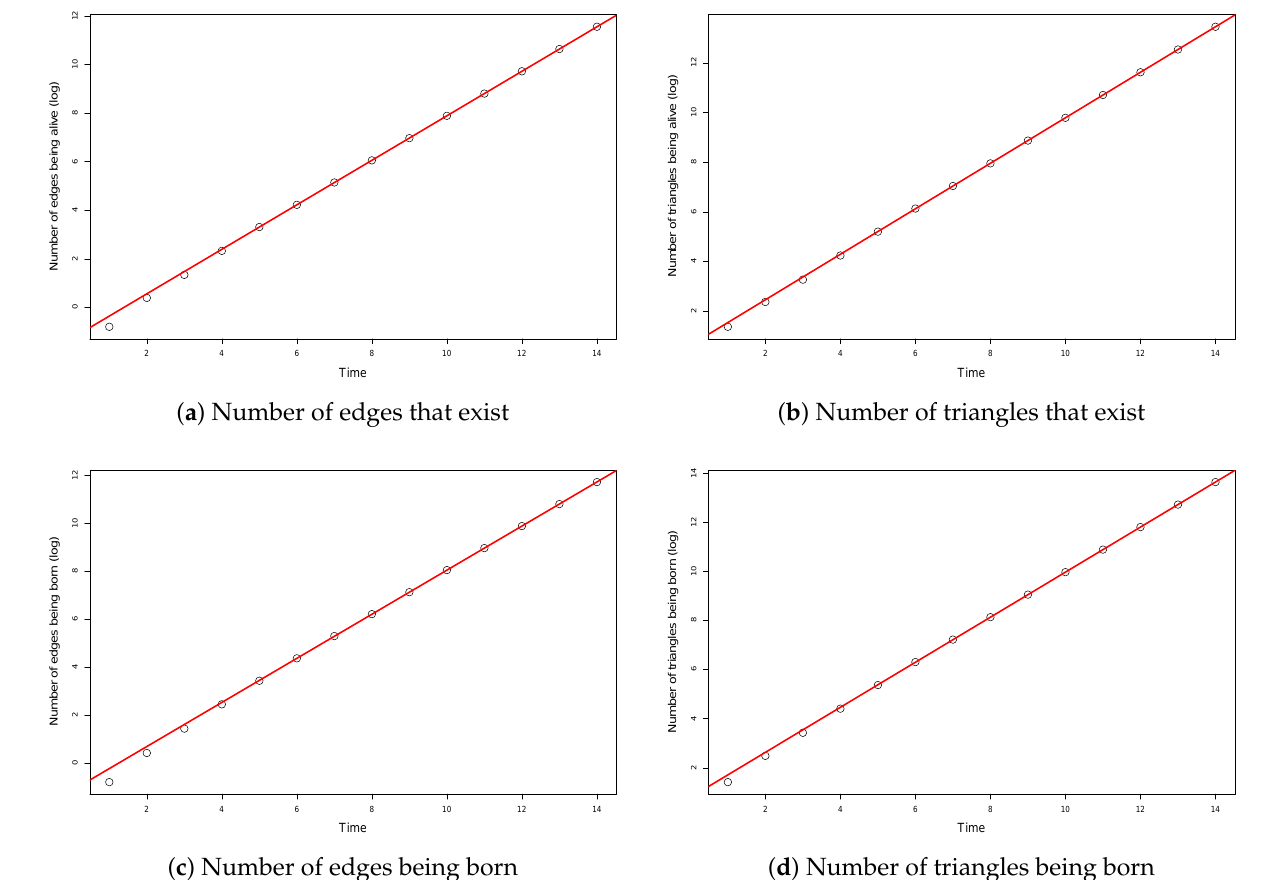
Figure 4. The average of 100 processes generated by the same parameter set and the regression